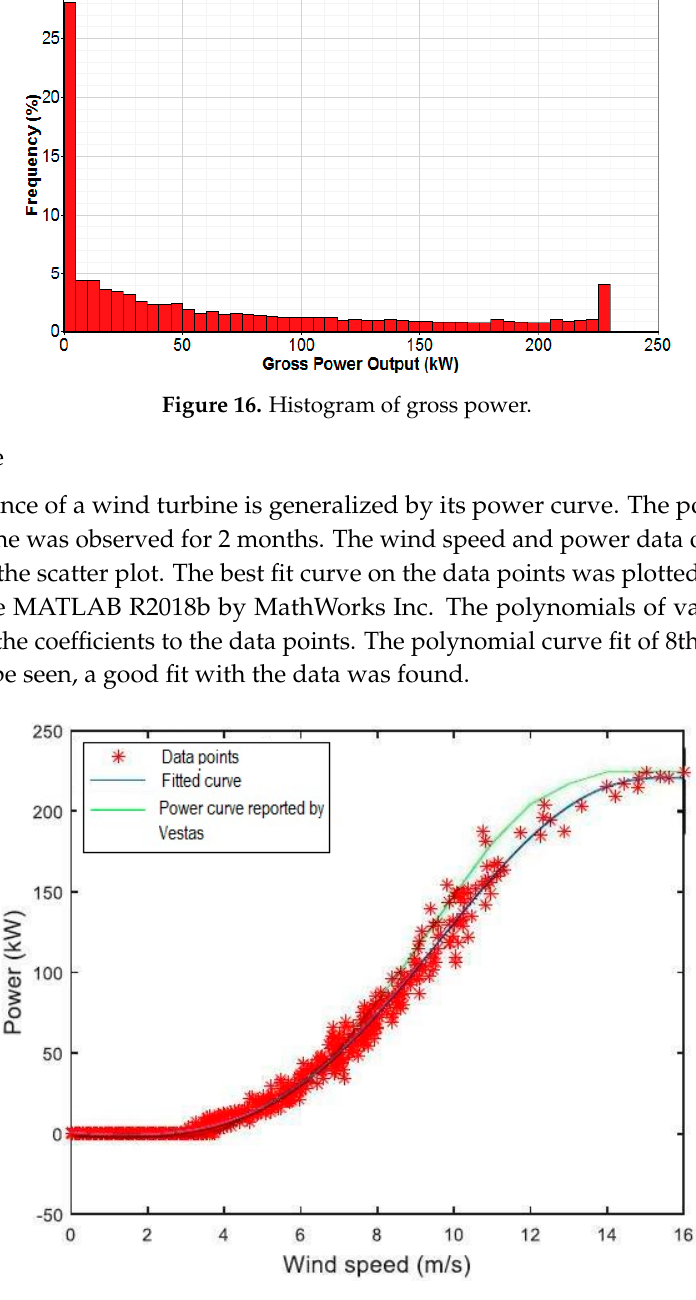
Figure 17. Power curve with scatter plot.